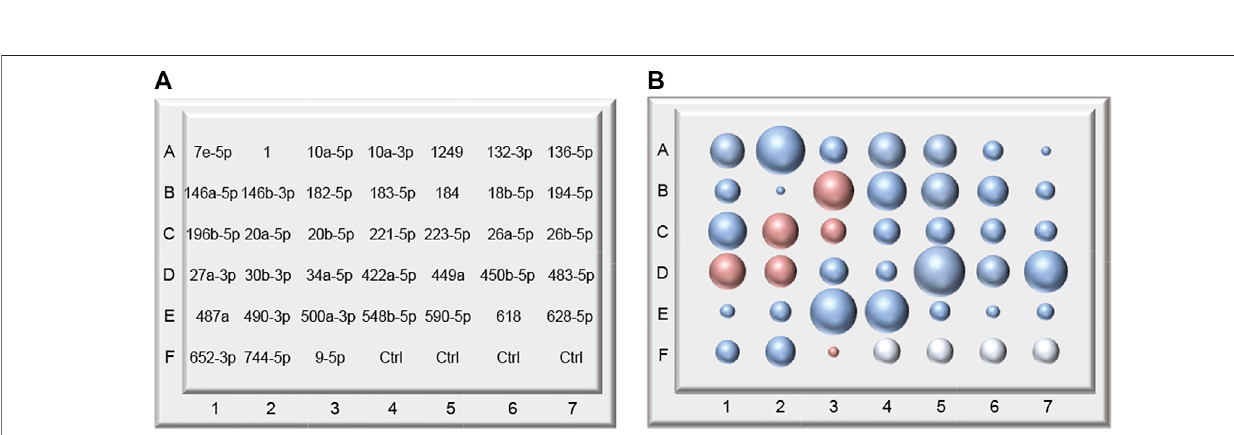
Frontiers in Genetics | www.frontiersin.org January 2022 | Volume 12 | Article 804222